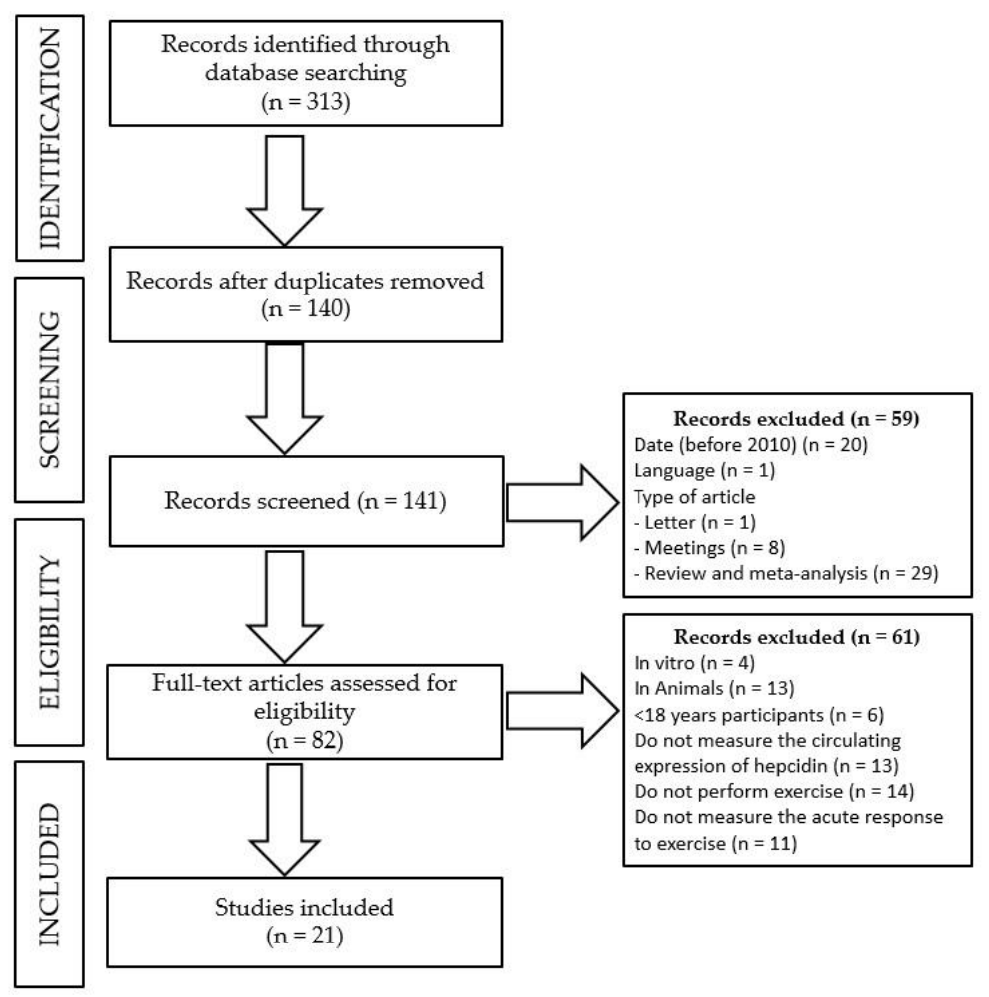
Figure 1. Flow diagram of the inclusion/exclusion process of the systematic review.